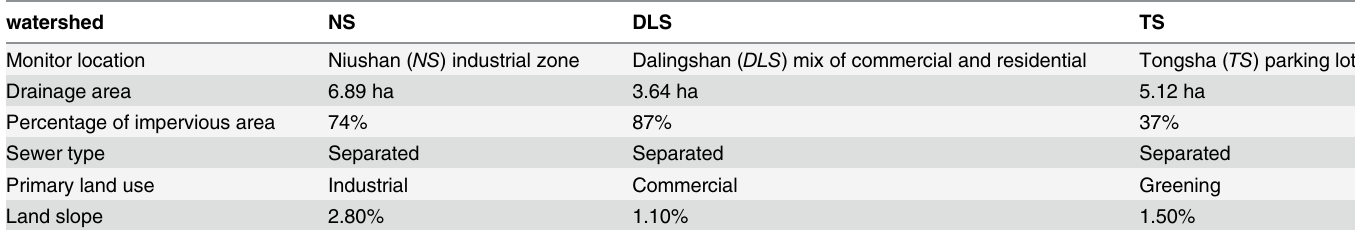
Table 1. Basic characteristics of the monitoring